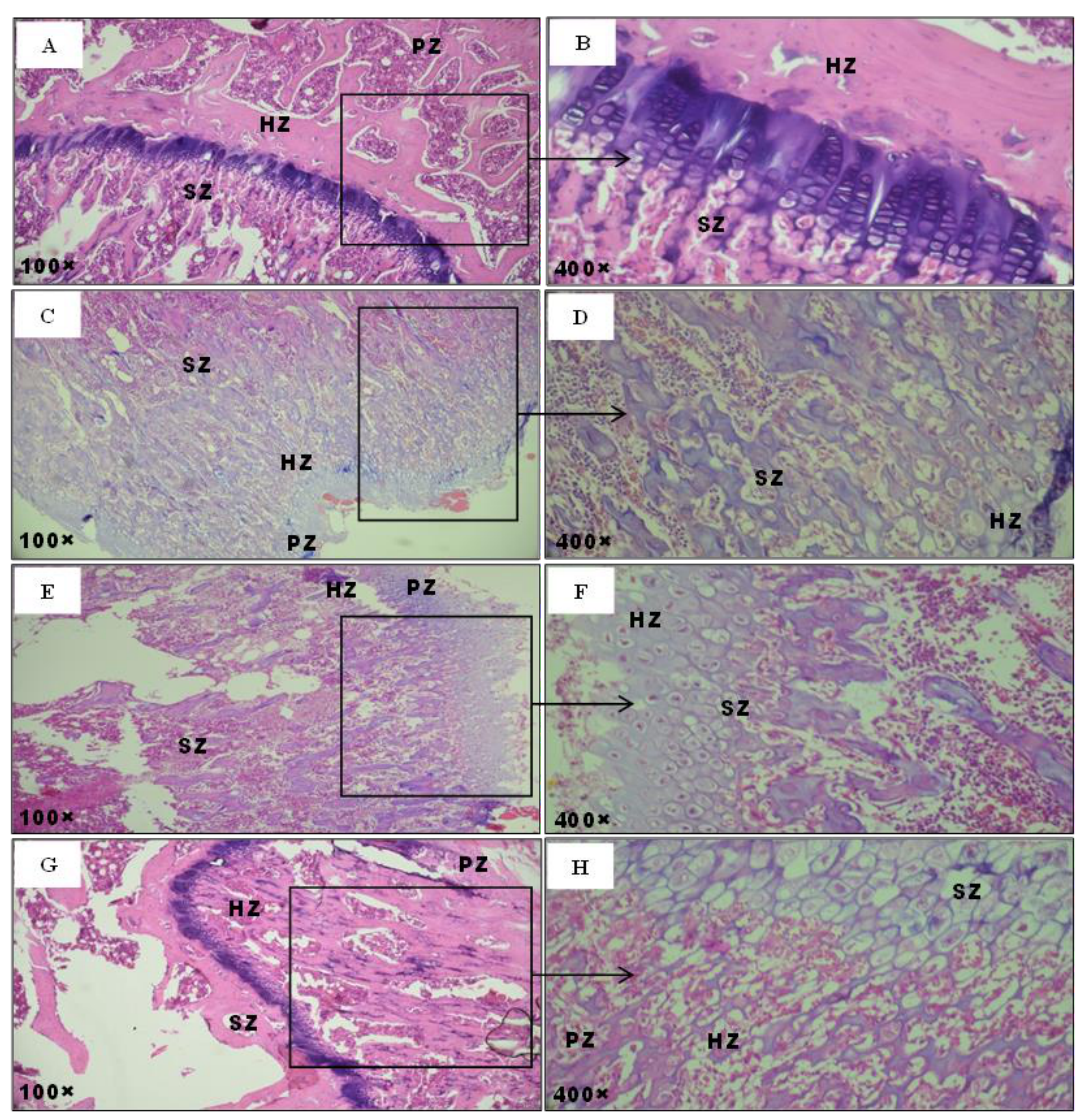
Figure 7. Optical microscopy histological sections of the femur stained with hematoxylin-eosin (H&E) of adult rats. ( A , B ) controls group; ( C , D ) rats treated with MT; ( E , F ) rats treated with MT + FRE; ( G , H ) rats treated with FRE. Arrows indicate the following: PZ: proliferative zone; HZ: hypertrophic zone; SZ: spongy zone.